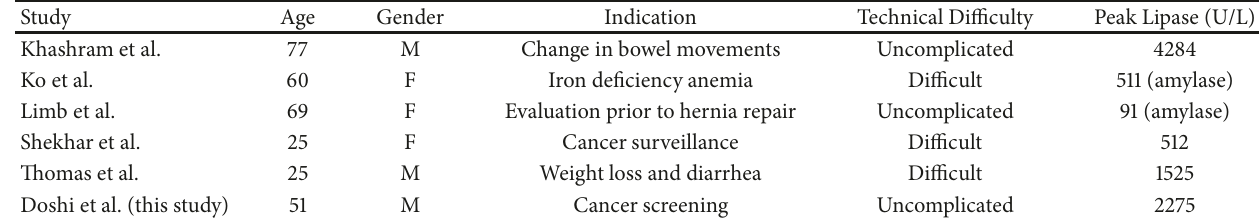
Table 1: Patient Characteristics of Case Reports of Acute Pancreatitis after Colonoscopy.